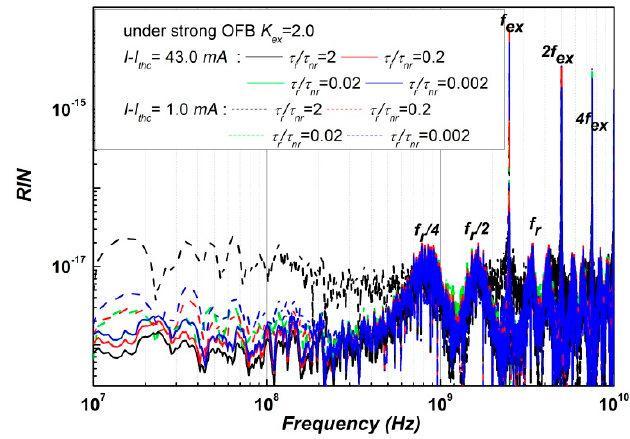
Figure 9. RIN under strong OFB at K ex = 2.0 and when I - I thc = 1.0 mA (dashed lines) and 43.0 mA (straight lines), and at τ r / τ nr = 2.0 (black), 0.2 (red), 0.02 (green), and 0.002 (blue).